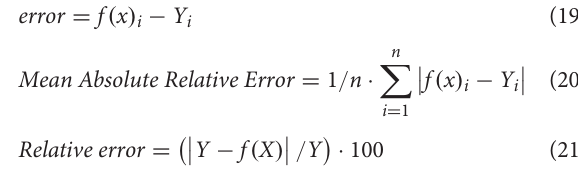
FIGURE 3 | Reactor 2 experimental carbon dioxide and calculated cumulative substrate degraded calculated from empirical glucose formula demonstrating a bi-phasic growth curve in the